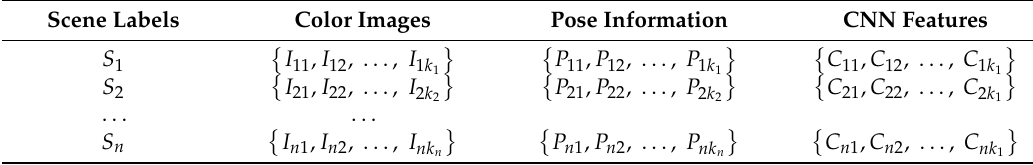
Table 1. Composition of